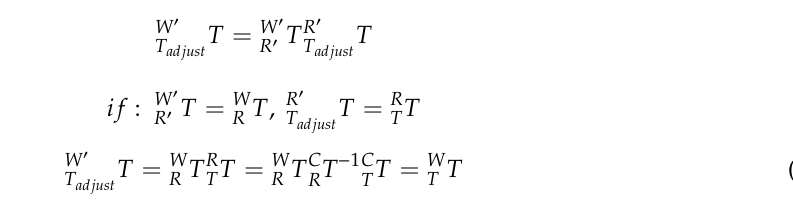
Figure 6. Introduction of the reference coordinate frame. (1) Tag of the reference coordinate frame {R}, (2) quick-hitch equipment, (3) hydraulic quick coupling (male), (4) tags of the attachment dock spot coordinate frame {T}, and (5) attachment dock spot.